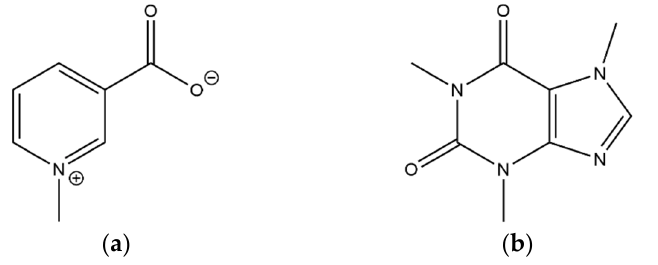
Figure 11 . Structure of the identified alkaloids: ( a ) trigonelline, ( b ) caffeine. Figure 11. Structure of the identified alkaloids: ( a ) trigonelline, ( b ) caffeine.